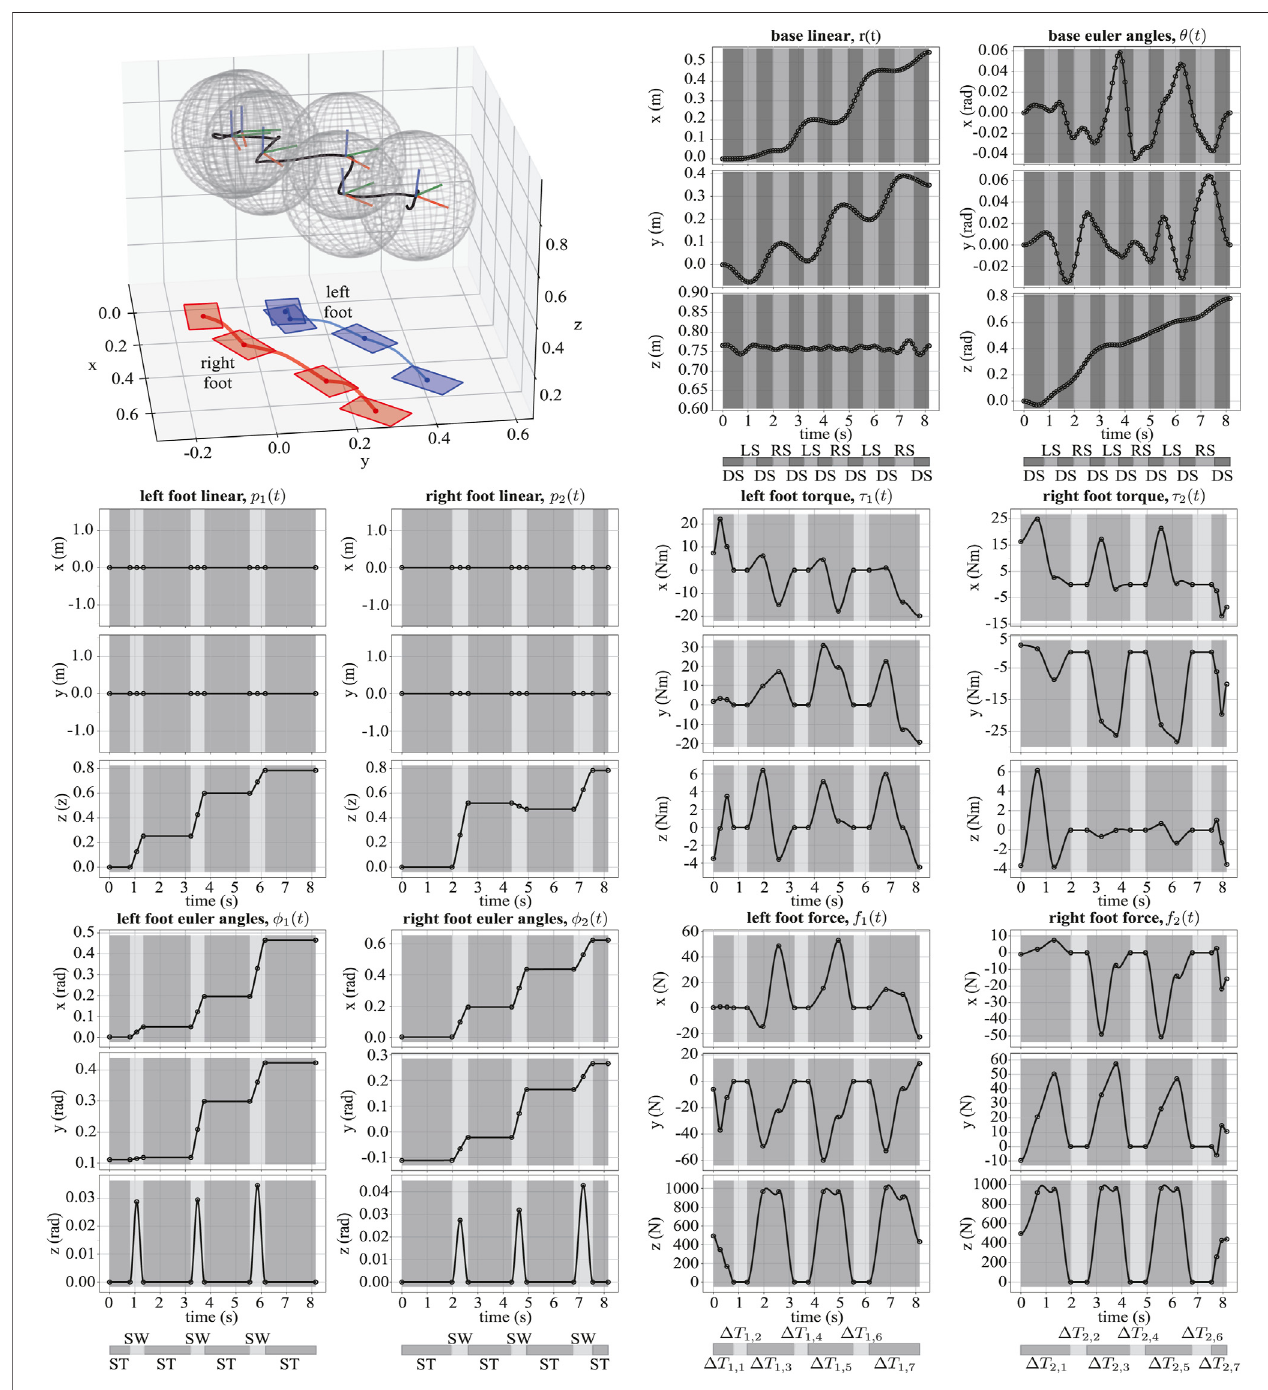
FIGURE 7 | We illustrate the trajectories for Valkyrie walking forward while turning. The upper left fi gure shows the motions in Cartesian space with varying centroidal inertia ellipsoids.